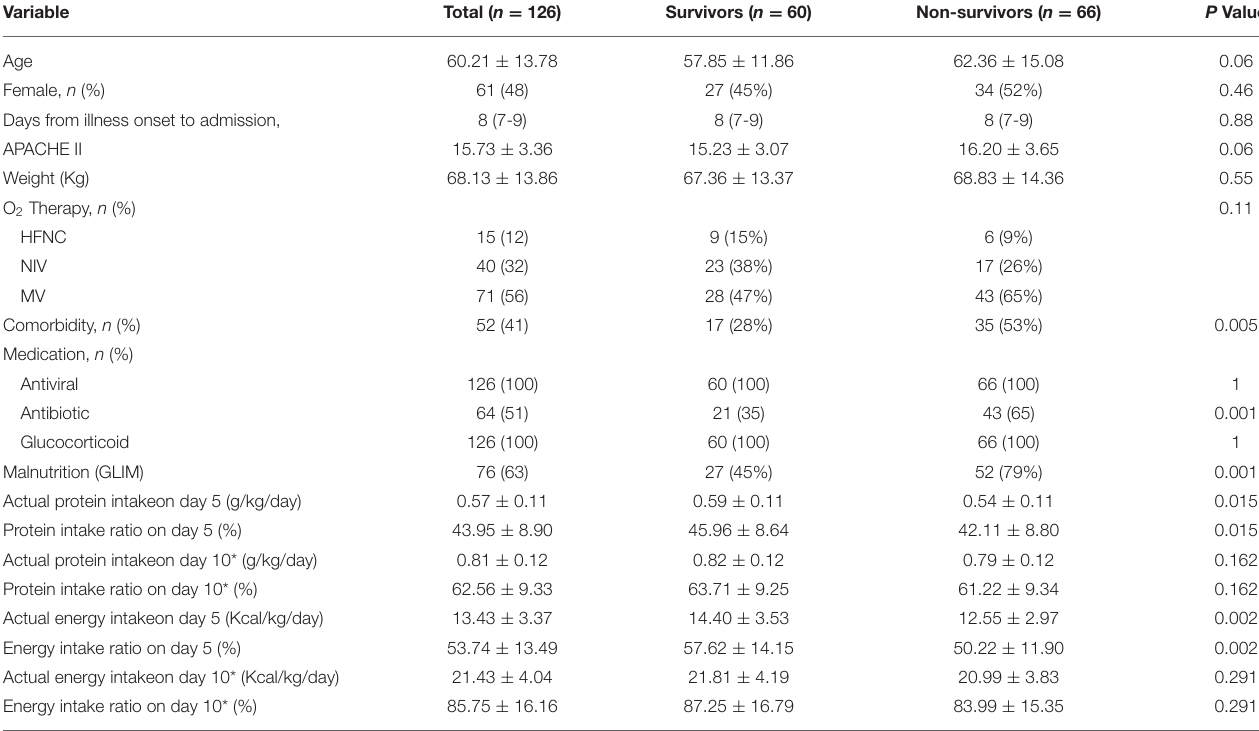
TABLE 1 | Baseline and clinical characteristics of